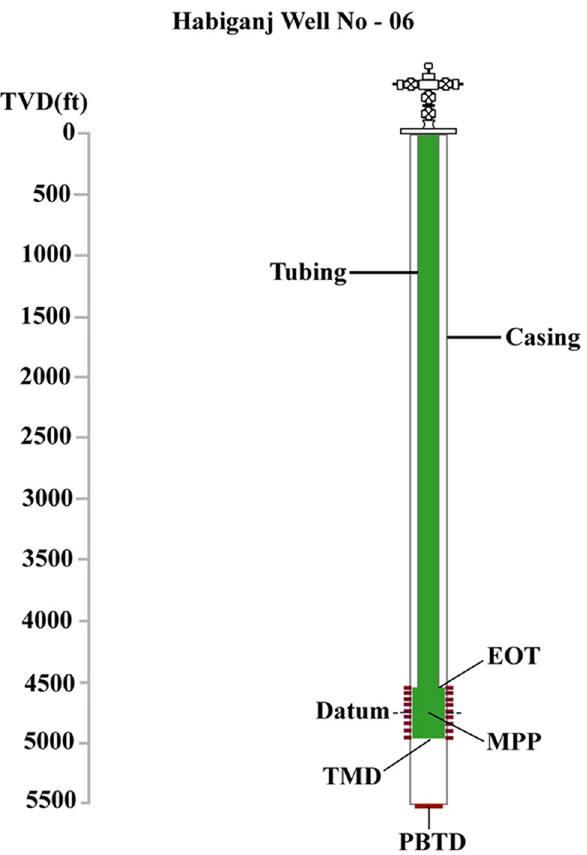
Fig. 5 Schematic diagram of vertical wellbore configuration in the optimum condition of HBJ-06